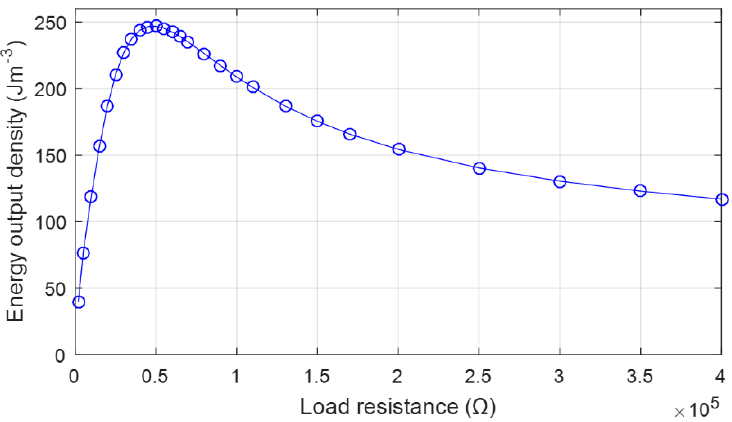
Figure 8. Energy output density with load resistance at the leading edge symmetric PZTs layers of wing root.